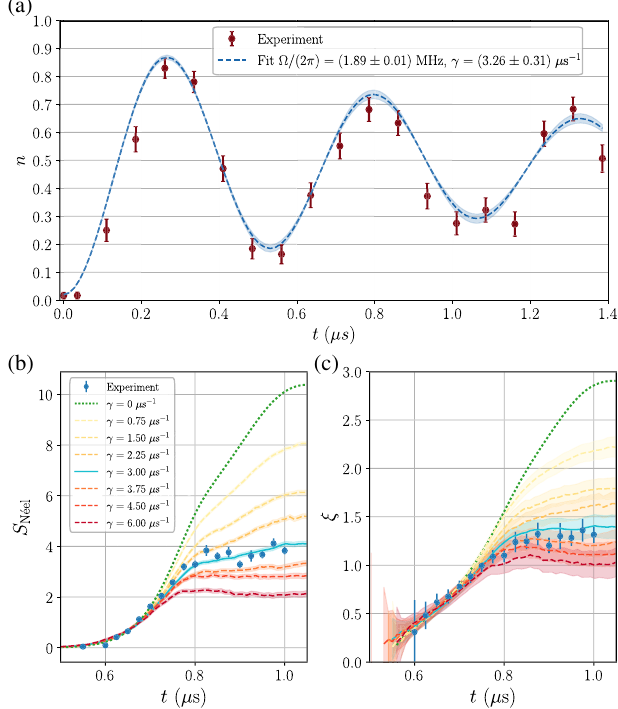
FIG. 8. (a) Single-atom Rabi oscillations, averaged over a typical square array (dark red symbols). We perform a fit (dashed line) to the analytical model including detection deficiency to obtain the dephasing rate γ and the Rabi frequency Ω . The value of γ thus obtained is then used for the simulations of the experiments Ω [cf. Figs. 3(c) and 3(d)]. (b),(c) Simulation of the with Ω max ¼ many-body real-time evolution as in Figs. 4(c) and 4(d), with different values of the dephasing rate γ for (b) the N´eel structure factor and (c) the correlation length. The rate γ ¼ 3 μ s − 1 used in the main text as obtained in (a) is indicated by a solid